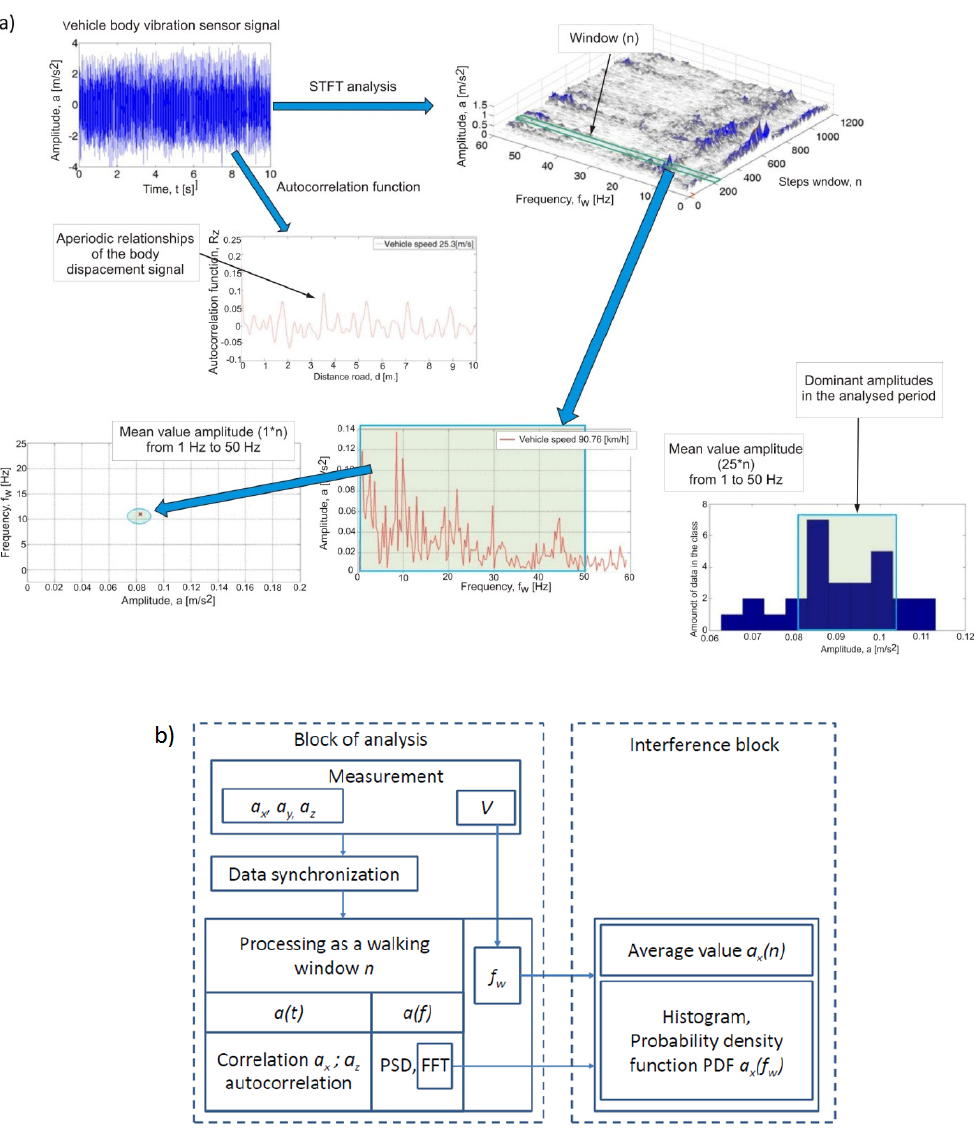
Figure 4. Diagram of processing data ( a ) and structure of measurement data analysis ( b ), where: a x , a y , a z —body linear accelerations (in x, y, z direction), V —vehicle linear speed, a (t)—acceleration analyzed in the time domain, a (f)—acceleration analysis in the frequency domain, f w —calculated wheel rotation frequency, a x (n)—average value of the acceleration spectrum in the x direction for the adopted frequency range (n), a x ( f w )—peak value of the acceleration spectrum in the x direction in the range of the wheel rotation frequency ( f w ). STFT: short term Fourier Transform.